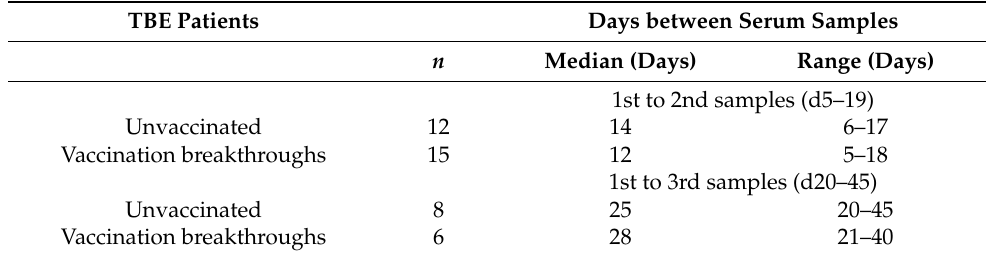
Table 2. Time intervals between first and one or two follow-up serum samples from TBE patients with and without prior vaccination.